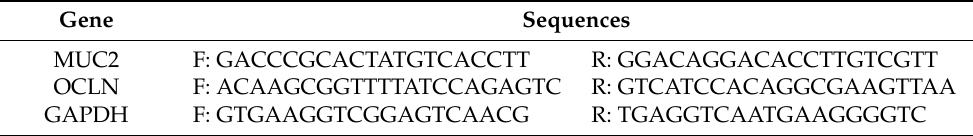
Table 2. The oligonucleotide primer sequences used in